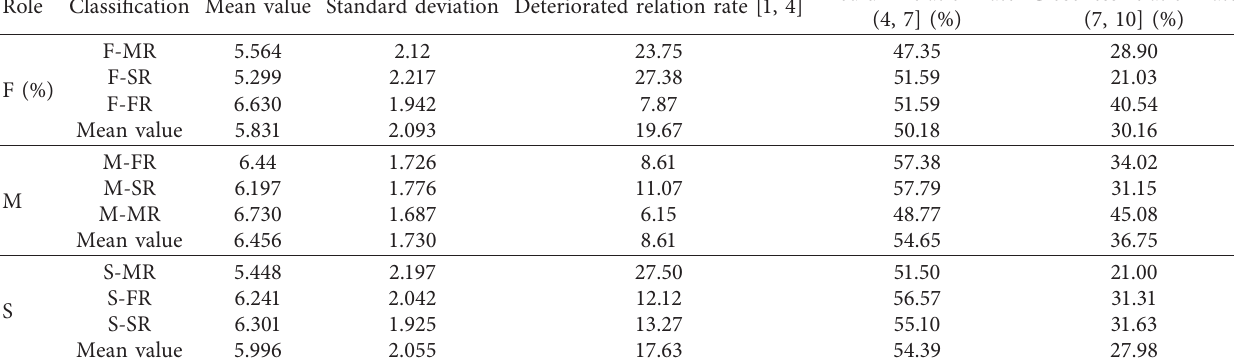
Table 4: Average analysis result of multirole relational